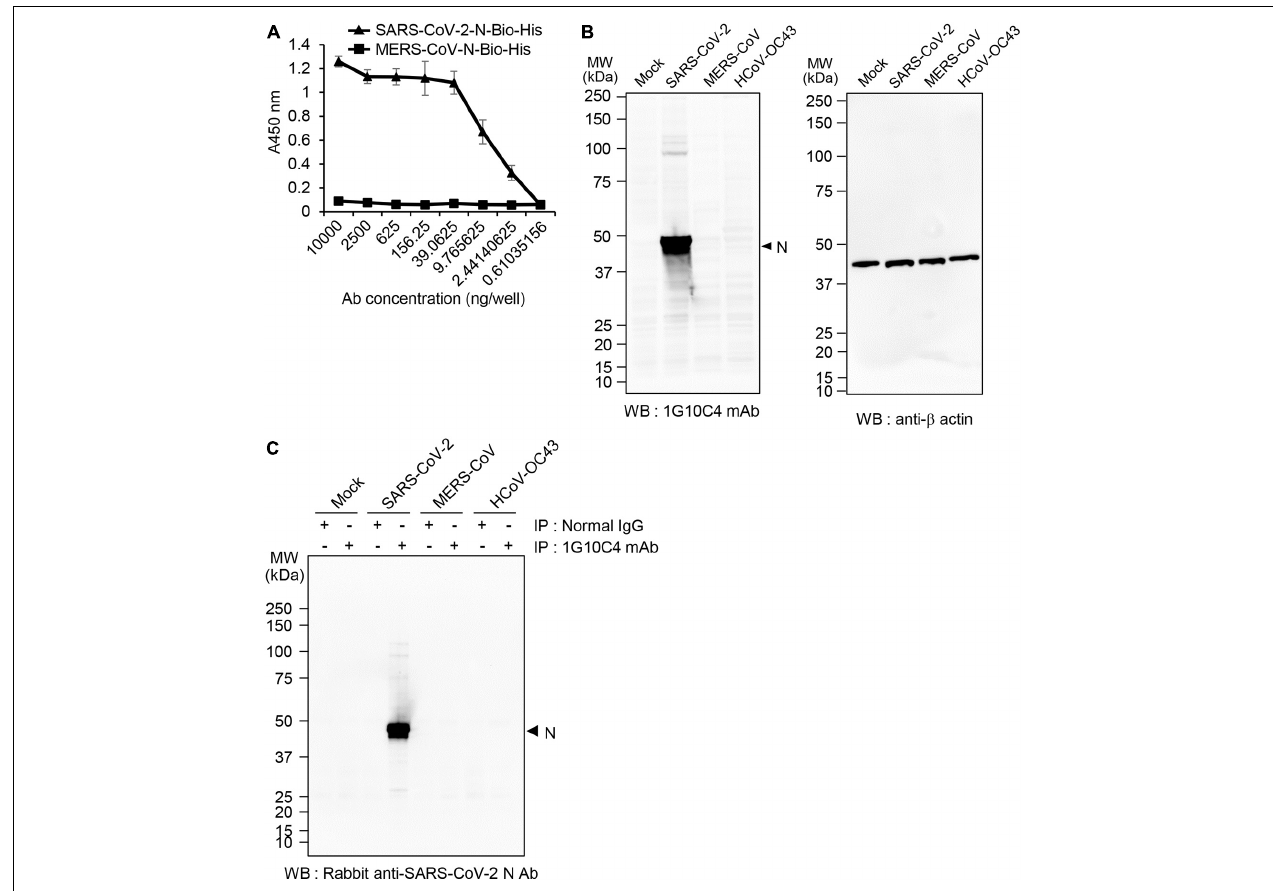
FIGURE 2 | Specificity of the anti-SARS-CoV-2 N protein monoclonal antibody. (A) Analysis of monoclonal antibody specificity. Recombinant SARS-CoV-2 N-Bio-His 6 protein or recombinant MERS-CoV N-Bio-His 6 protein was captured on streptavidin-coated 96-well immunoplates and then incubated with anti-SARS-CoV-2 N protein monoclonal antibody. Reactivity of the monoclonal antibody to each recombinant protein was determined by ELISA. (B) MERS- CoV-, SARS-CoV- 2-, or HCoV-OC43-infected and non-infected Vero cell lysates were immunoblotted with the anti-SARS-CoV-2 N protein monoclonal antibody (clone 1G10C4 mAb). β -Actin was used as the loading control. (C) MERS- CoV-, SARS-CoV- 2-, or HCoV-OC43-infected and non-infected Vero cell lysates were immunoprecipitated with normal mouse IgG or the anti-SARS-CoV-2 N protein monoclonal antibody (clone 1G10C4 mAb). The immunocomplexes were subjected to western blot analysis using rabbit anti-SARS-CoV-2 N protein antibody (Catalog No. 40588-T62; Sino Biological).